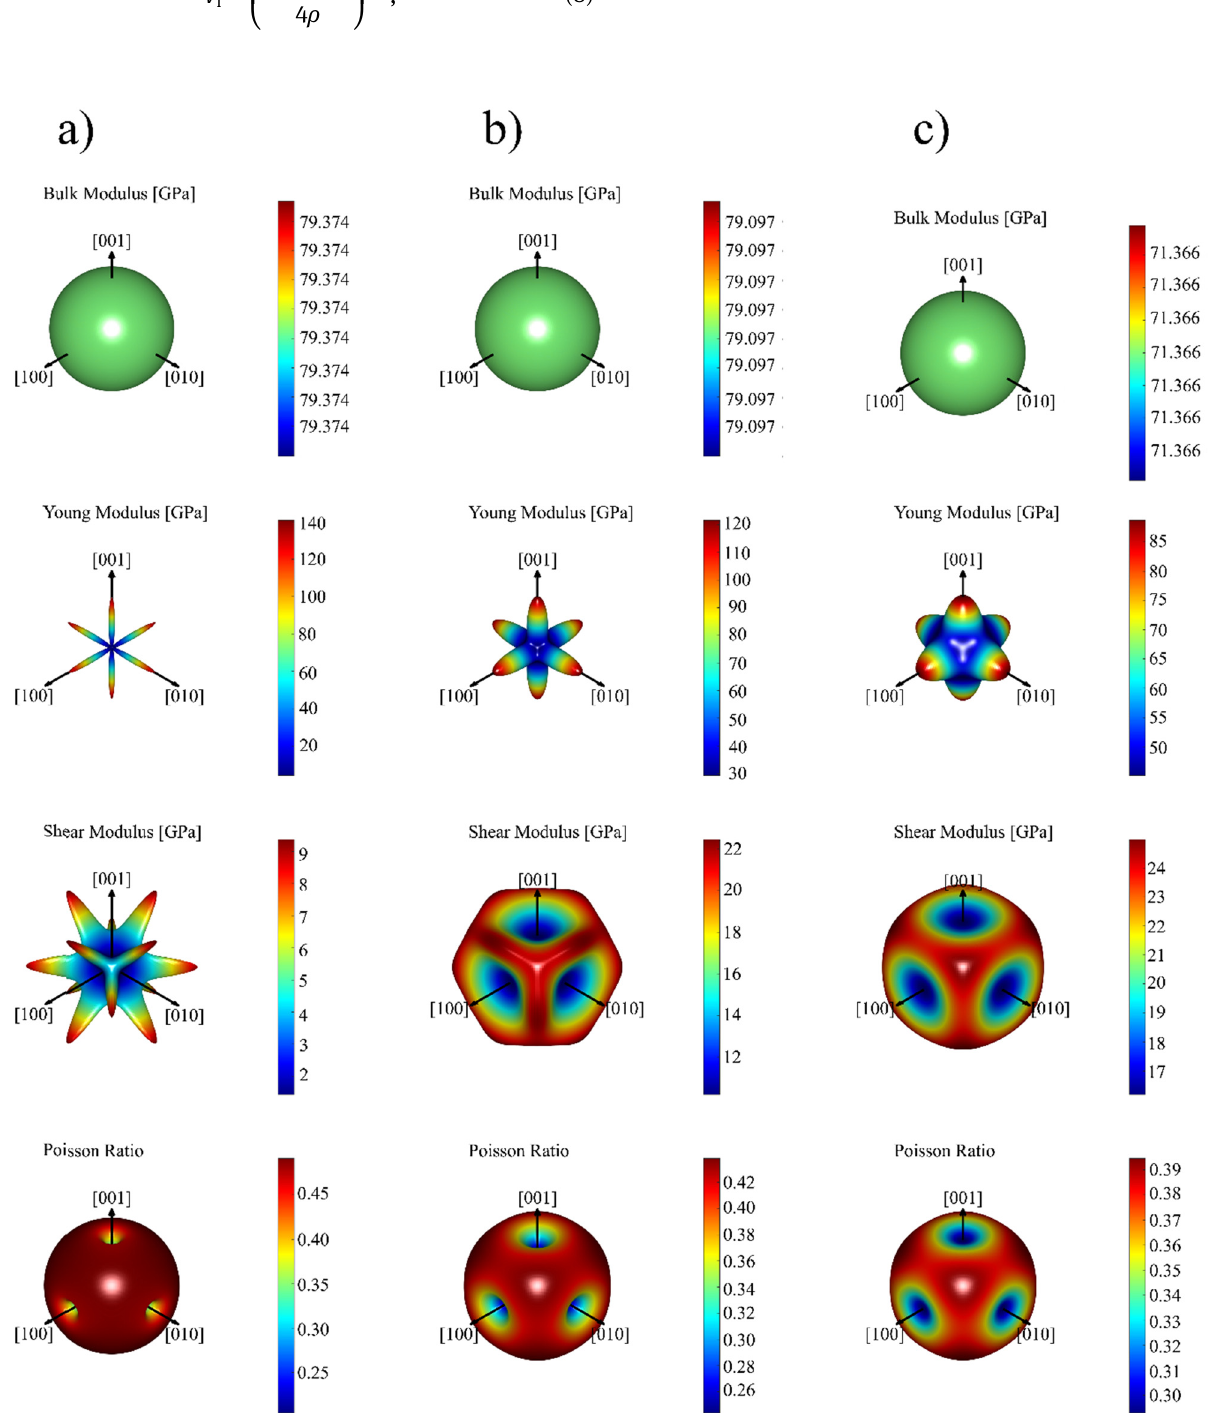
Figure 2: The graphical notation of polycrystalline properties for XInO 3 ( X = K, Rb, and Cs ) compounds. ( a ) KInO 3 , ( b ) RbInO 3 , and ( c ) CsInO 3